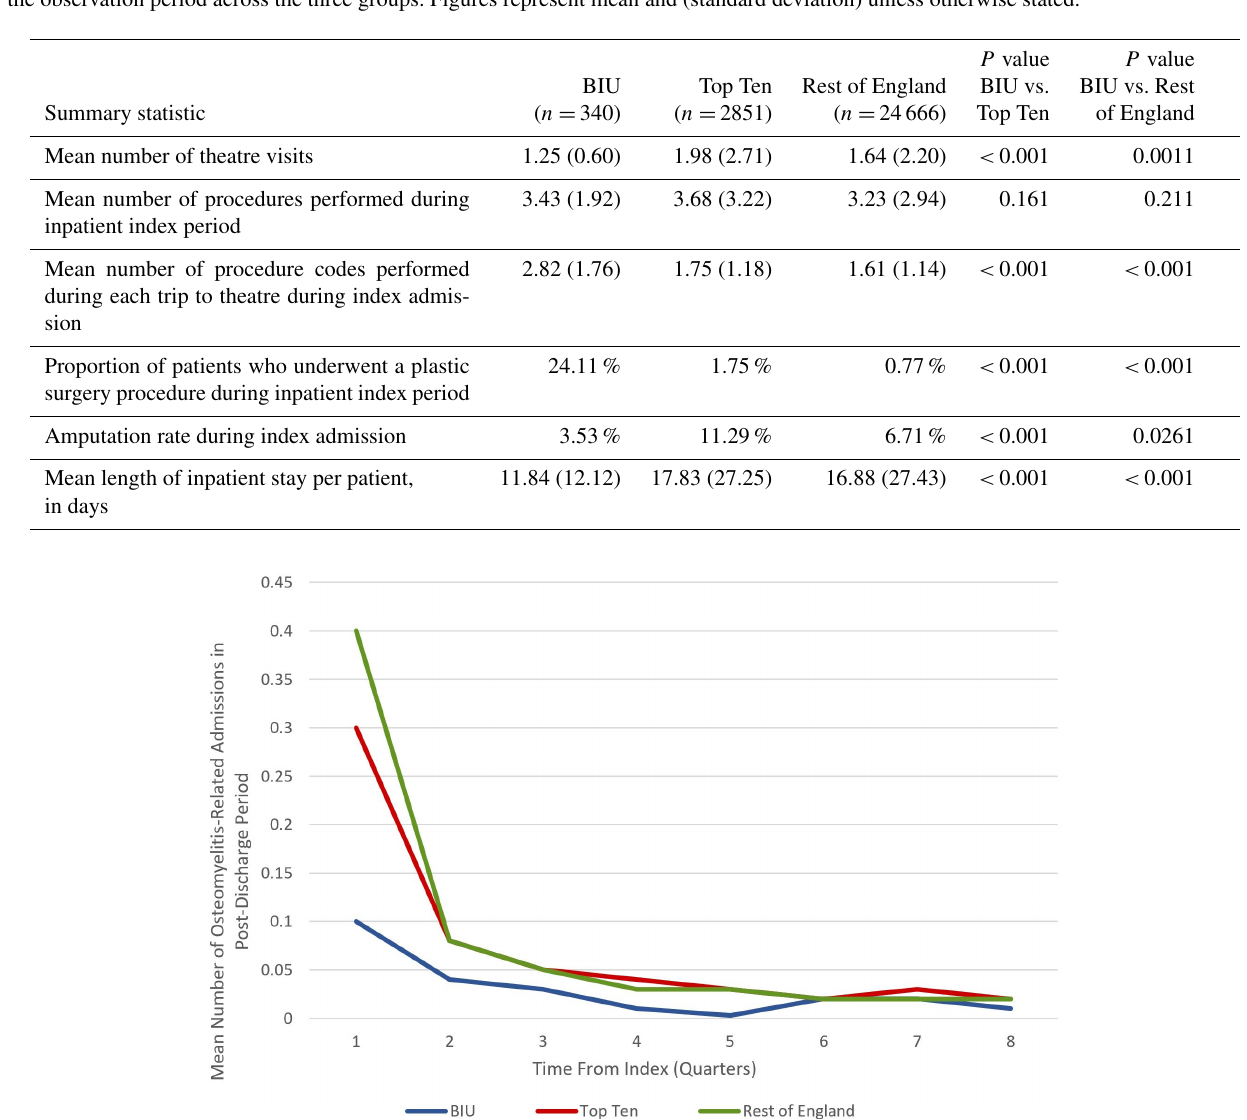
Figure 2. Mean number of osteomyelitis-related admissions during the 24-month post-discharge period at the BIU, Top Ten and the rest of